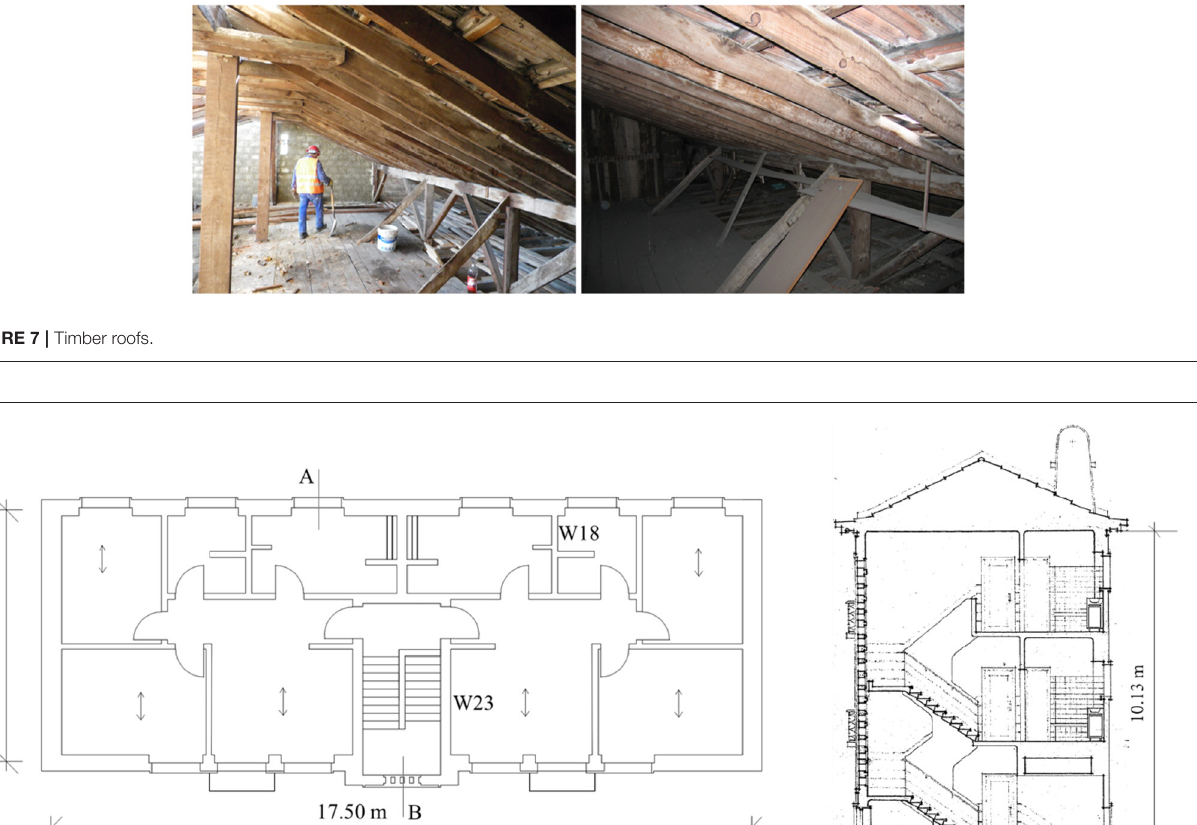
Tremuri program (3Muri 2 ; Lagomarsino et al., 2013) and by performing nonlinear static analysis. The nonlinear response of masonry panels, concentered at walls divided into piers